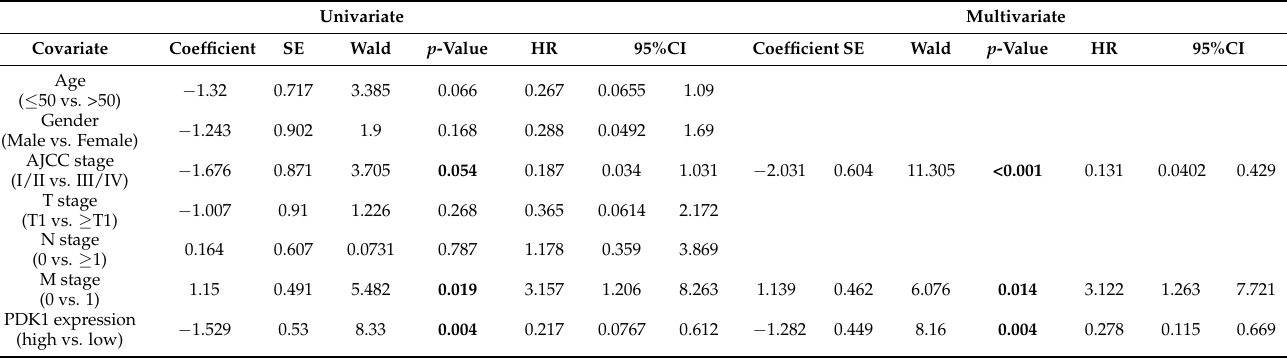
Table 2. American Joint Committee on Cancer (AJCC) OSCC staging criteria and patient 5-years overall survival. Univariate